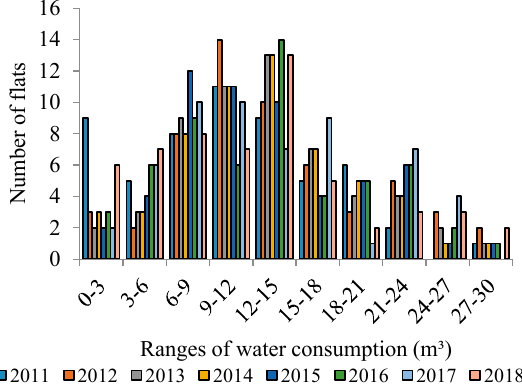
Figure 5. Histogram, separated per class of water consumption and per year, relative to monthly averages of water consumption in the flats (it does not include water consumption in toilets).